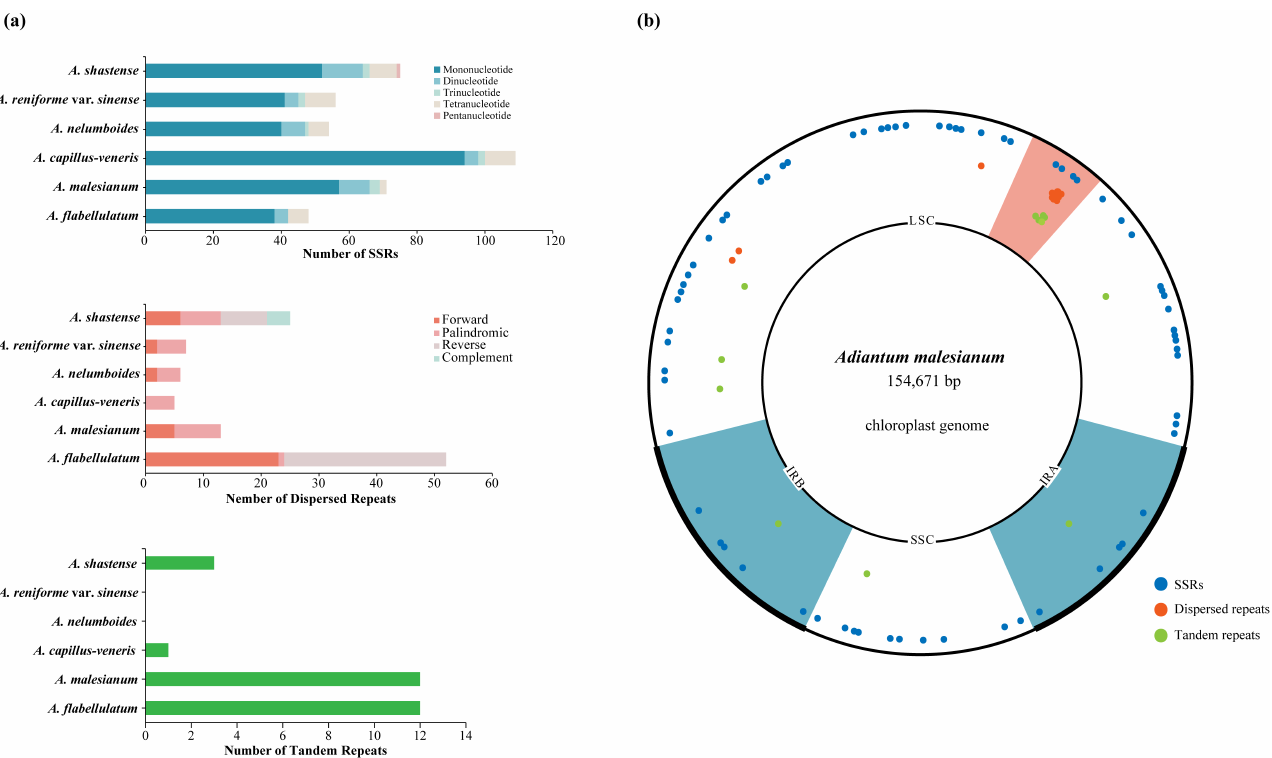
Figure 5. ( a ) Comparative analysis of repeated sequences in the six Adiantum cp genomes. The number of SSRs ( above ), dispersed repeats ( middle ) and tandem repeats ( below ) are presented. ( b ) Distribution pattern of SSRs, dispersed repeats and tandem repeats in the A. malesianum cp genome. Blue regions are IRs; the red region is the rpoB-trnD-GUC IGS. Dots indicate relative positions of the